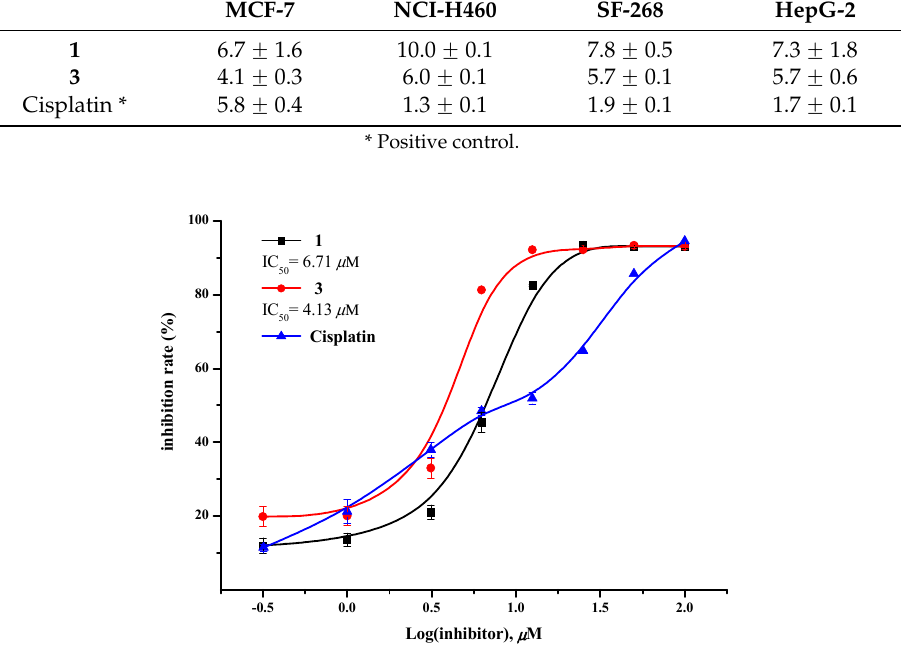
Figure 3. Growth inhibitory curves of compounds 1 , 3 and cisplatin (positive control) against MCF-7. Table 2. Growth-inhibition effects of compounds 1 and 3 .